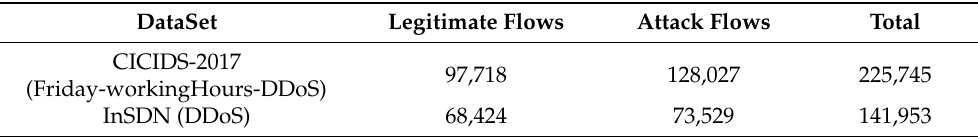
Table 5. Flow distribution between CICIDS-2017 and InSDN